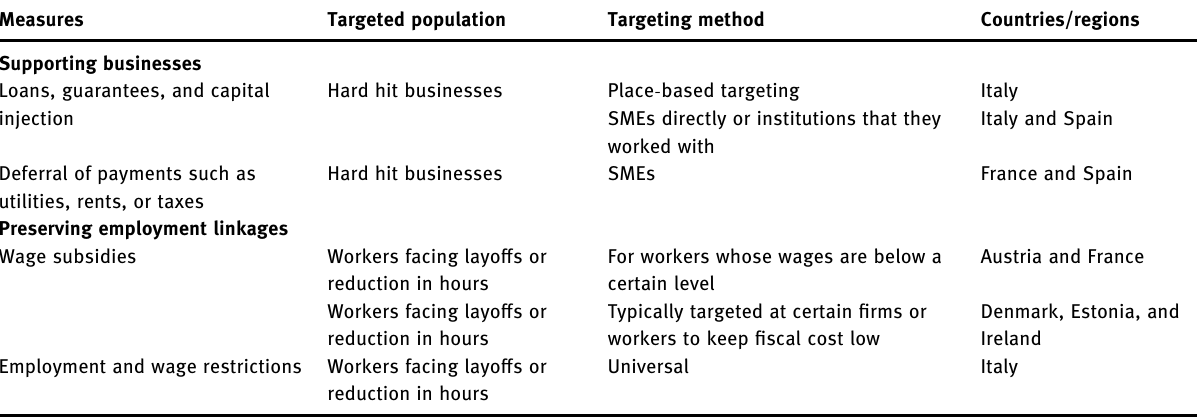
Table 4: Expenditure policy responses to COVID - 19 outbreak